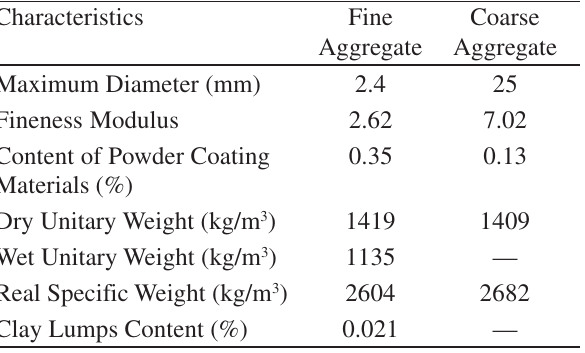
Table 1. Characteristics of Main Aggregates.